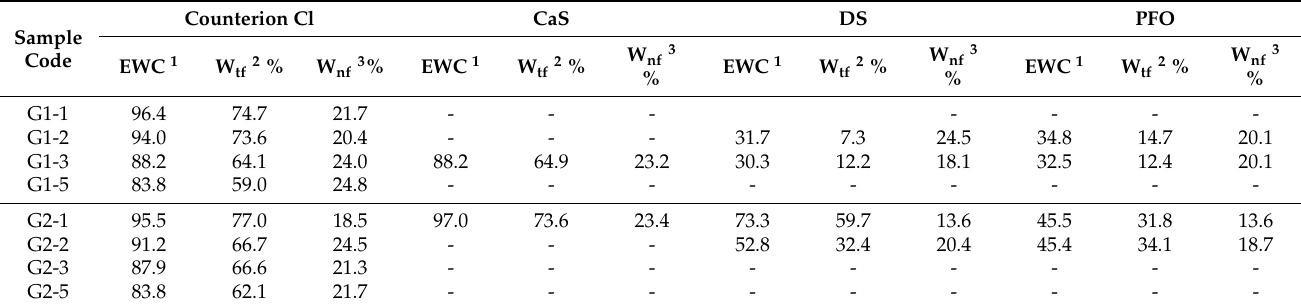
Table 3. Water state characterization in the hydrogels, before and after the anion